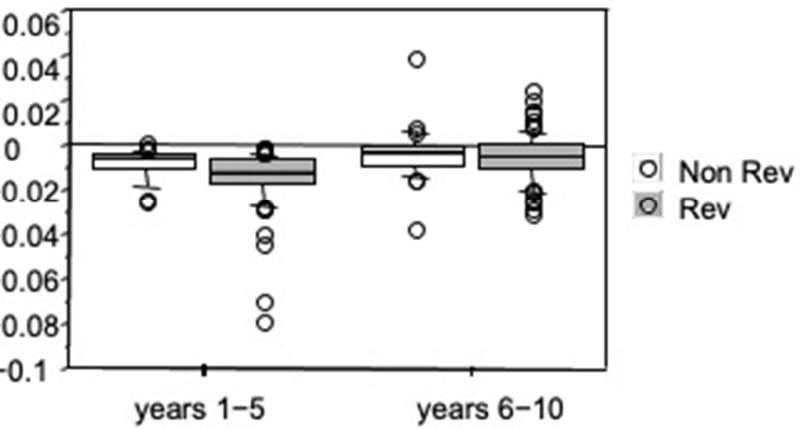
Figure 4. Slope values of relationships between height-adjusted FEV 1 and time (L/m 3 /year) during